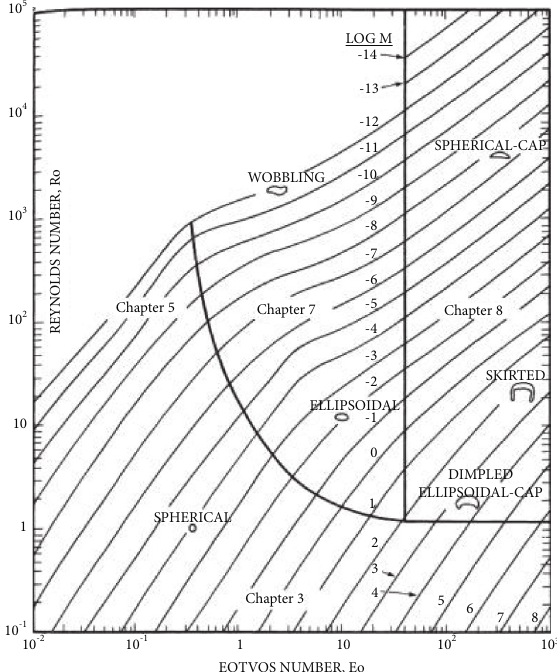
Figure 2: The diagram of the bubble shapes drawn by Clift et al.